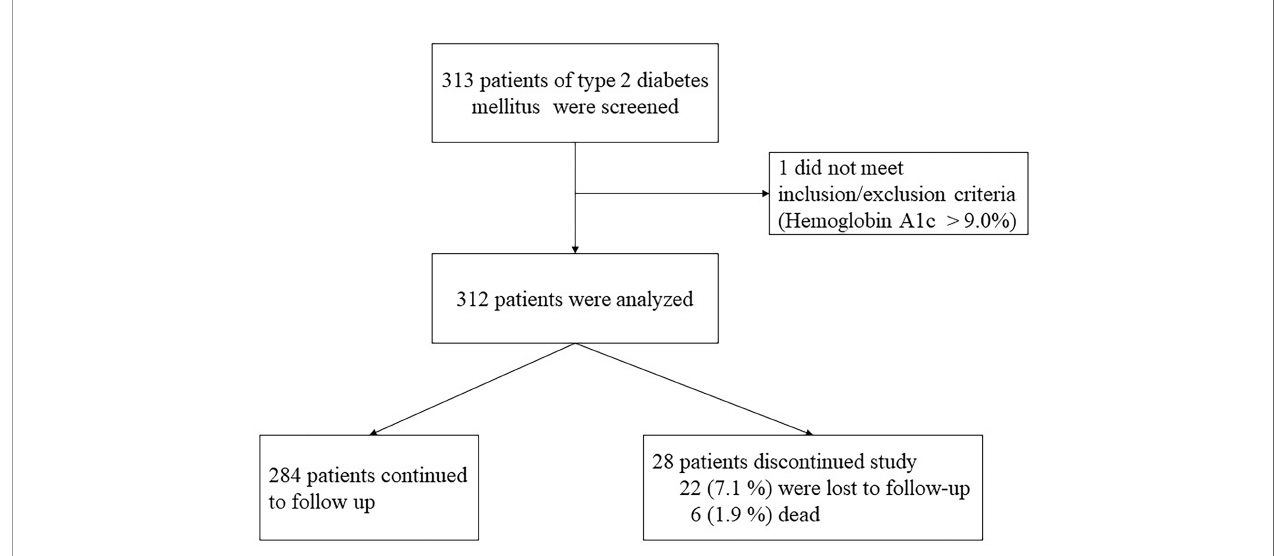
FIGURE 1 | Patient